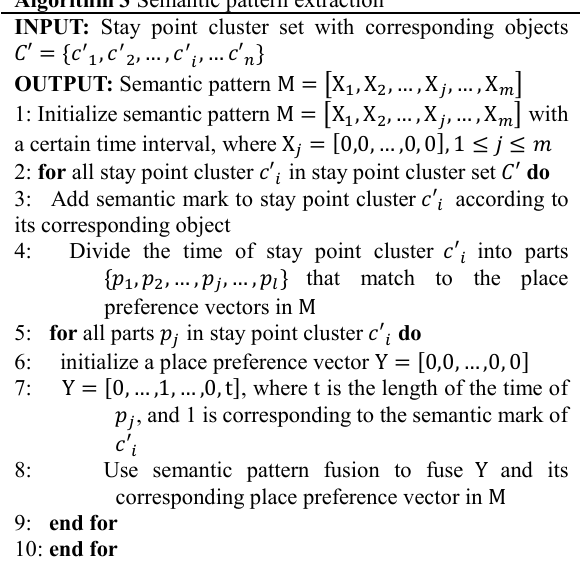
Algorithm 3 Semantic pattern